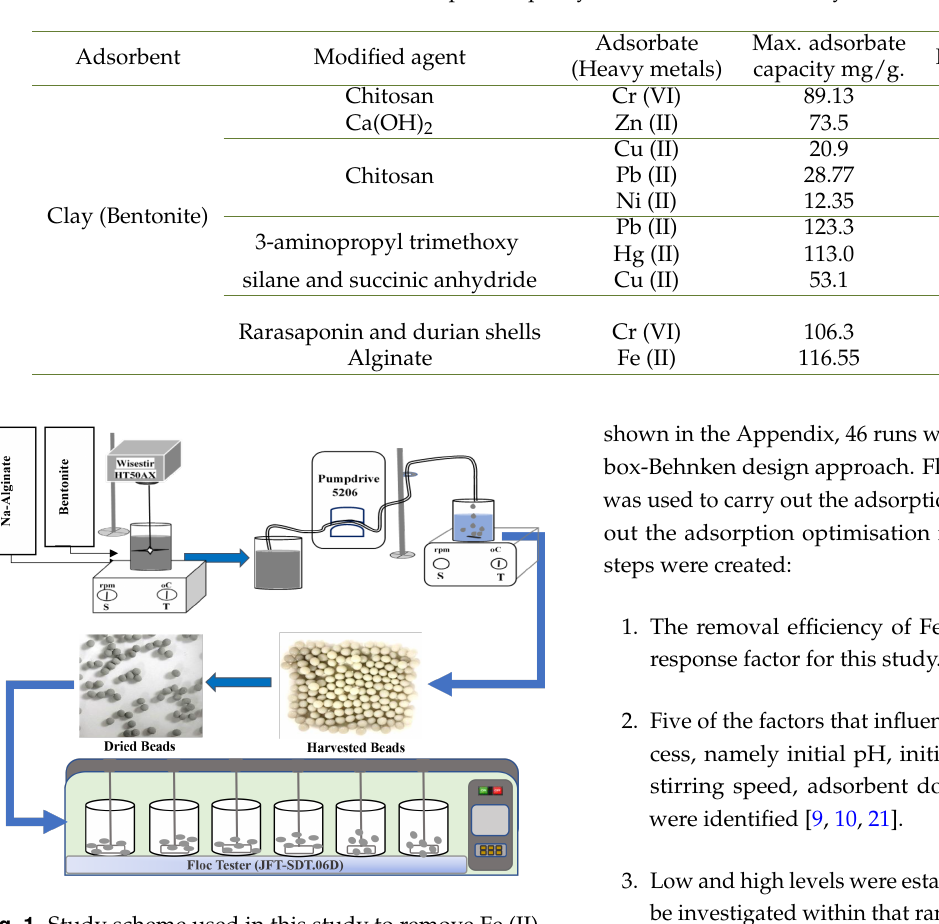
Table 2. Adsorption capacity for various modified clay